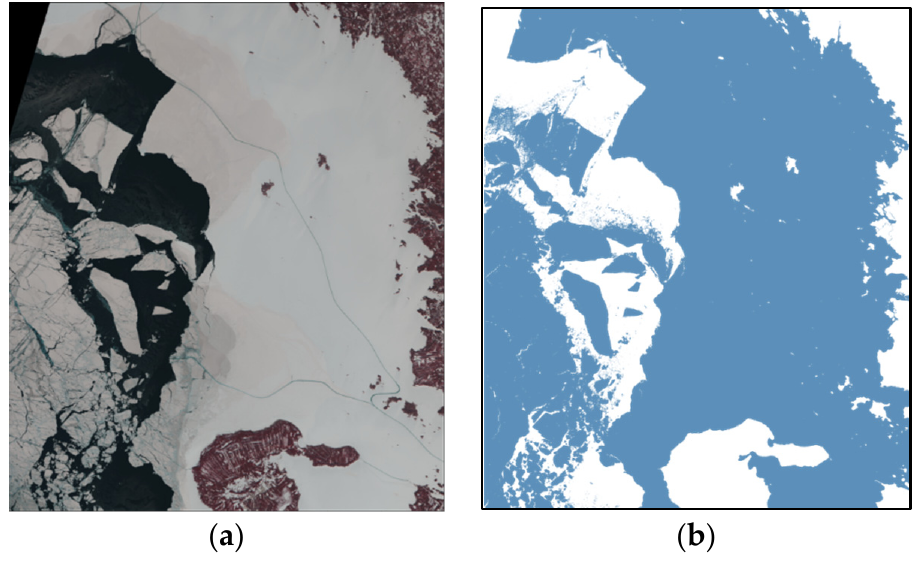
Figure 4. ( a ) Landsat-8, 16 February 2021; ( b ) Ice mask (blue). The ice mask was overlaid with the BSH ice charts to create the training data using the ICESOD codes, Figure 5a. The polygons from the BSH charts were rasterized and a code was assigned to every pixel. Additional ice free values were retrieved using the water mask which is obtained by subtracting the ice mask from the inverted land mask, Figure 5b.